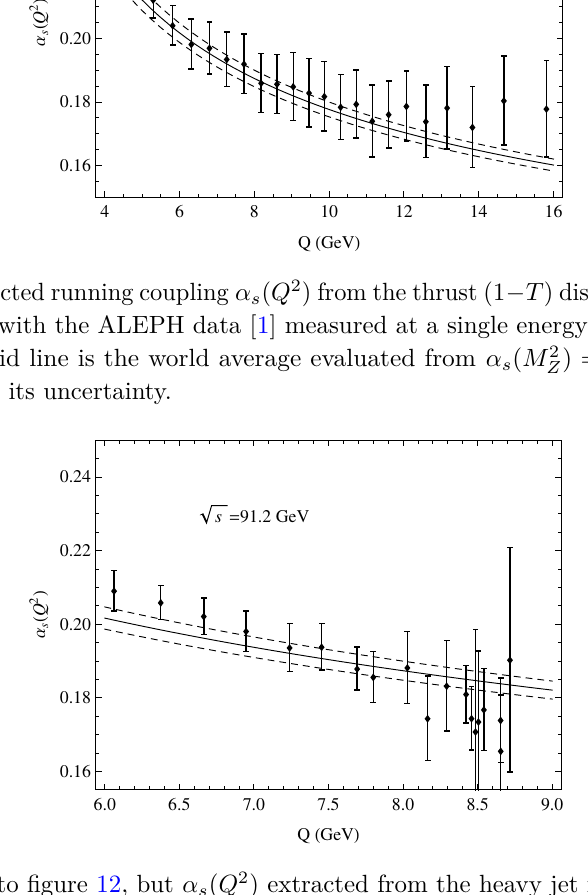
Figure 13. Similar to figure 12, but α s ( Q 2 ) extracted from the heavy jet mass ( ρ ) distribution.